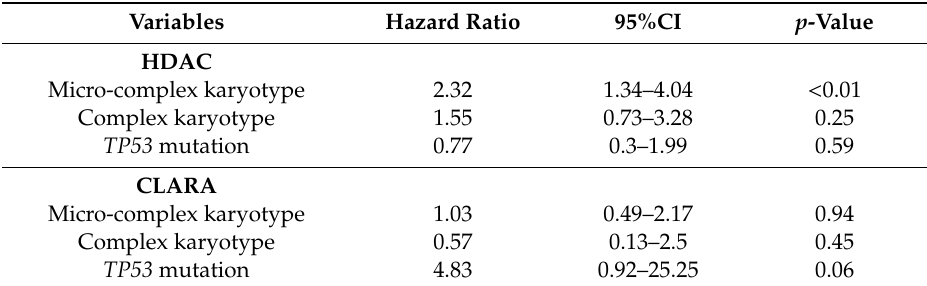
Table 1. Multivariate Cox model analysis of relapse-free survival (RFS).